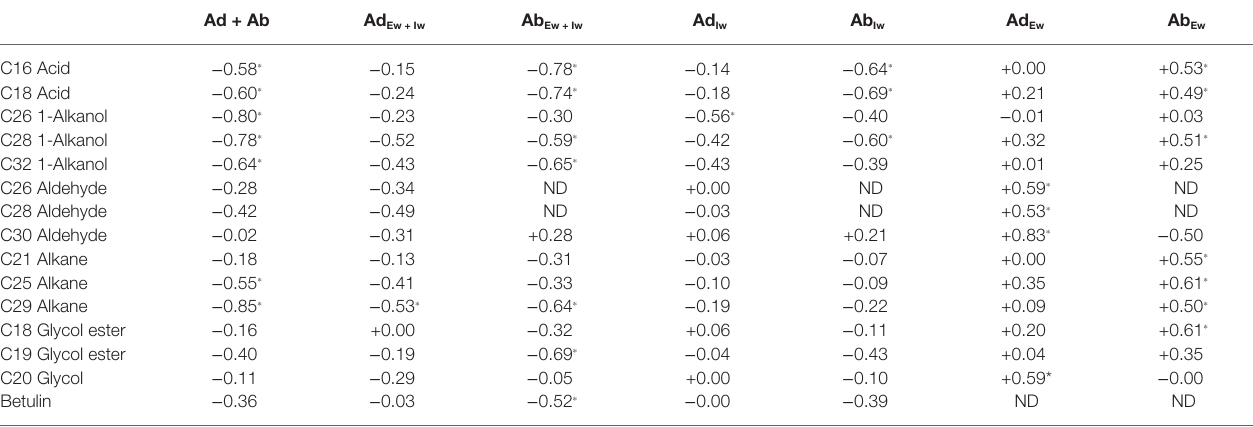
TABLE 2 | Correlation analysis between cuticular transpiration rate (or resistance) and cuticular wax components ( R 2